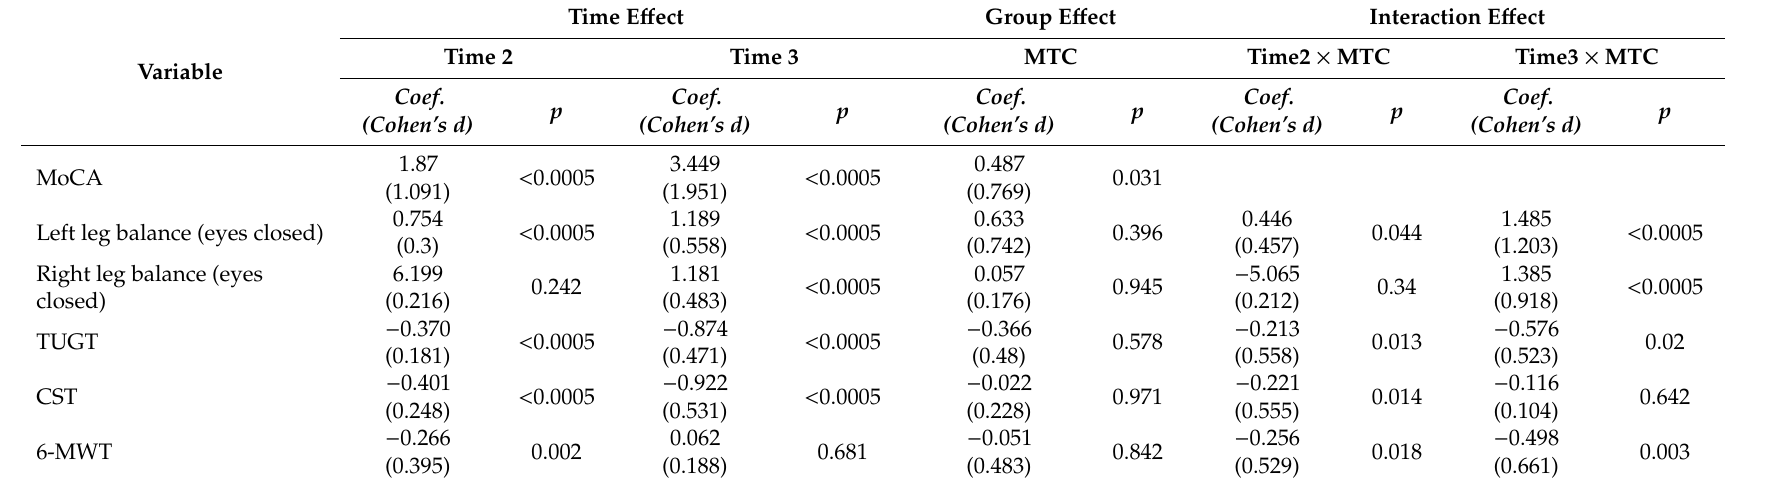
Table 2. Parameter estimation and significance of coe ffi cients in the GEE models.